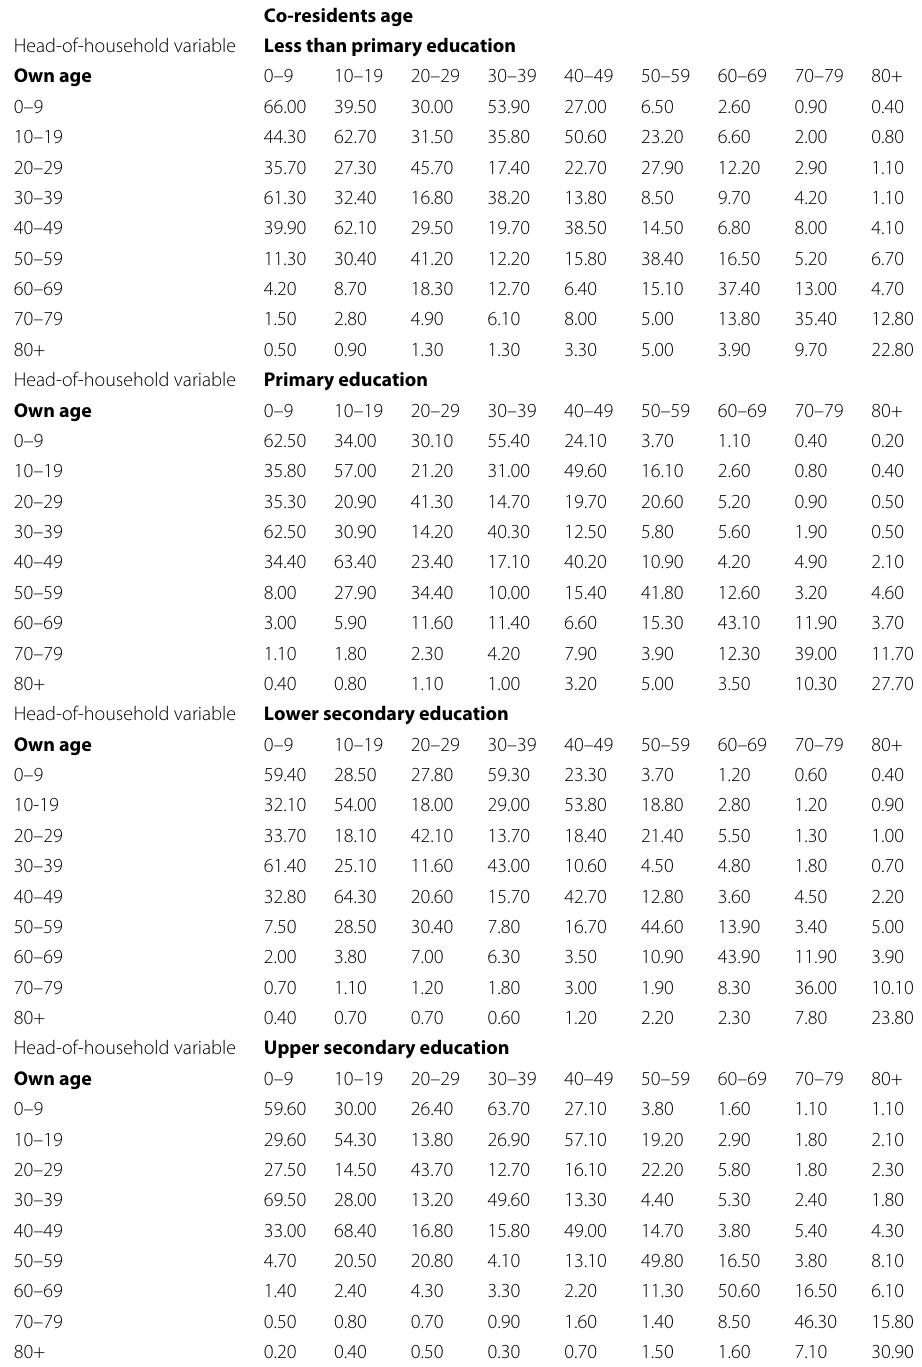
Table 11 Proportion of individuals with at least one co-resident by age and head-of-household education